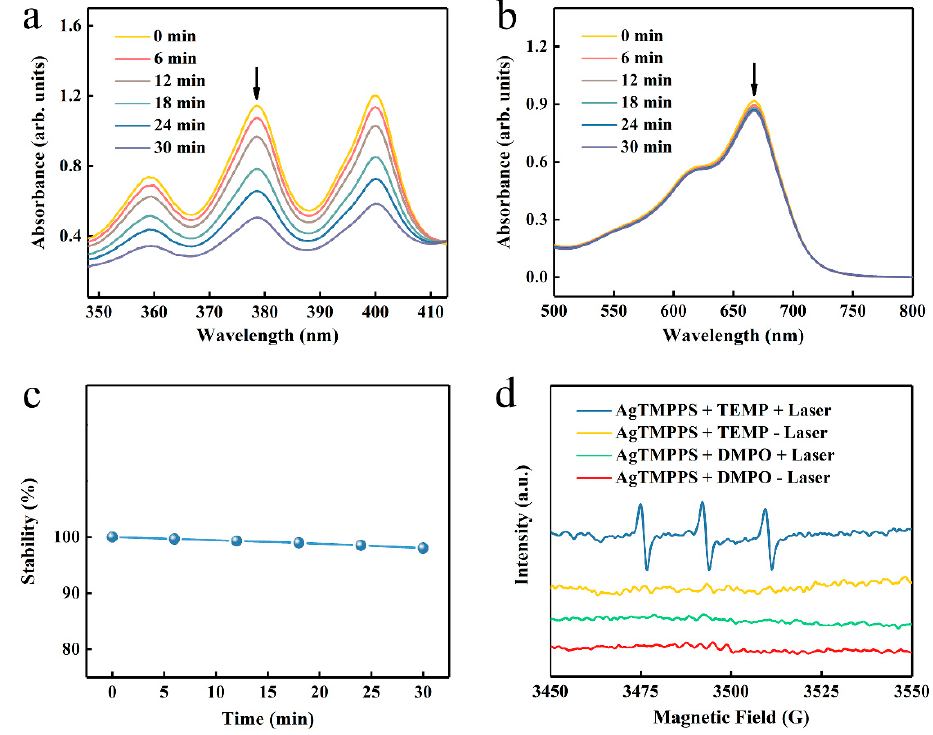
Figure 4. ROS generation by AgTMPPS under laser irradiation (460 nm, 0.05 W/cm 2 ). ( a ) Time-de- pendent absorption of ABDA, suggesting the generation of 1 O 2 by AgTMPPS under laser